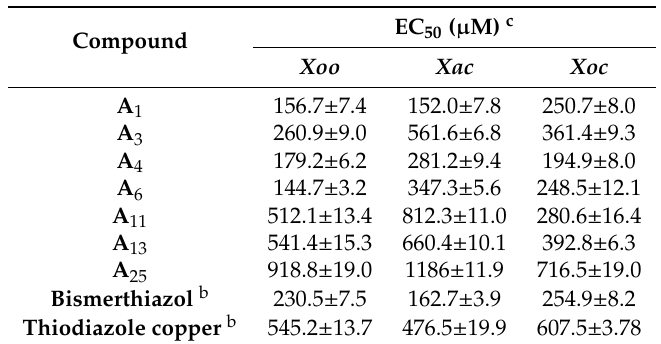
Table 1. EC 50 ( µ M) values of some target compounds against Xoo , Xac and Xoc a